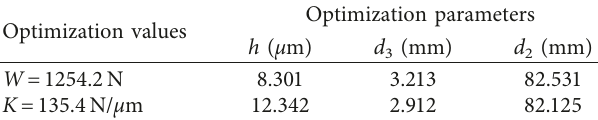
Table 1: Optimal results of single objective